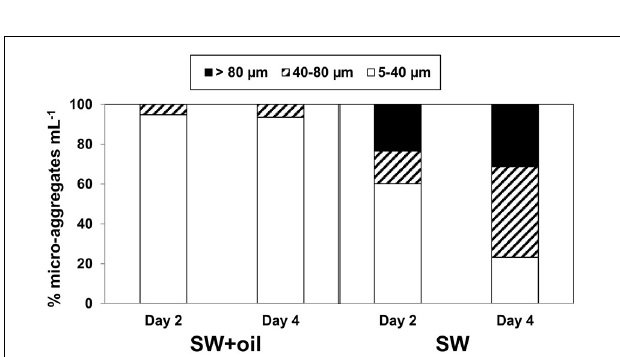
FIGURE 4 | Size distributions of bacterial micro-aggregates in GOE. Percentage distribution of three aggregate size classes in the seawater without GCS-oil (SW), and with GCS-oil (SW + GCS-oil).